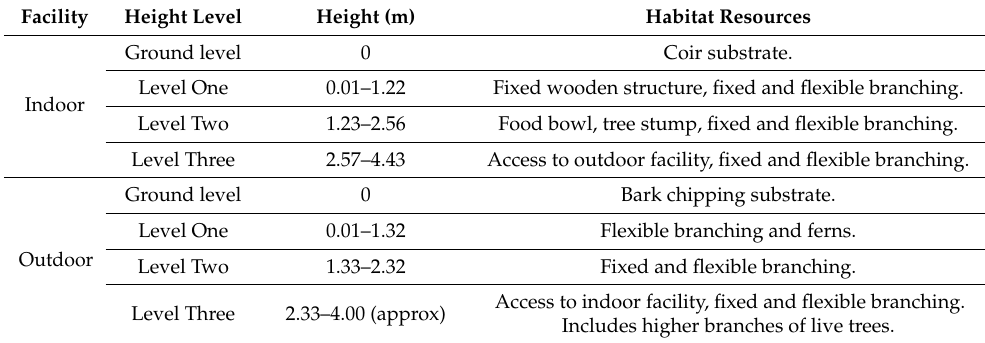
Table 1. Indoor and outdoor facility height levels were used to quantify height utilisation. Outlined are the name of the height level, height in meters of each level and relevant habitat resources within each